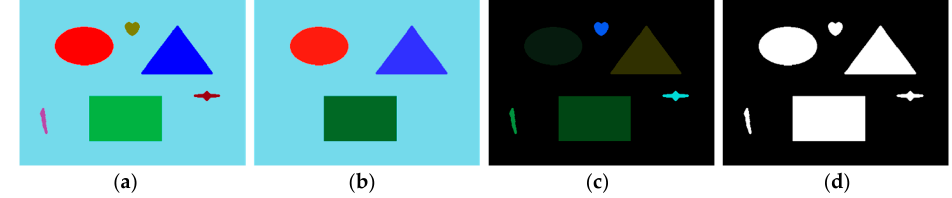
Figure 3. Change detection based on the difference in grayscale value: ( a ) image 1, ( b ) image 2, ( c ) the difference image, and ( d ) threshold segmentation (the threshold is 0.4).